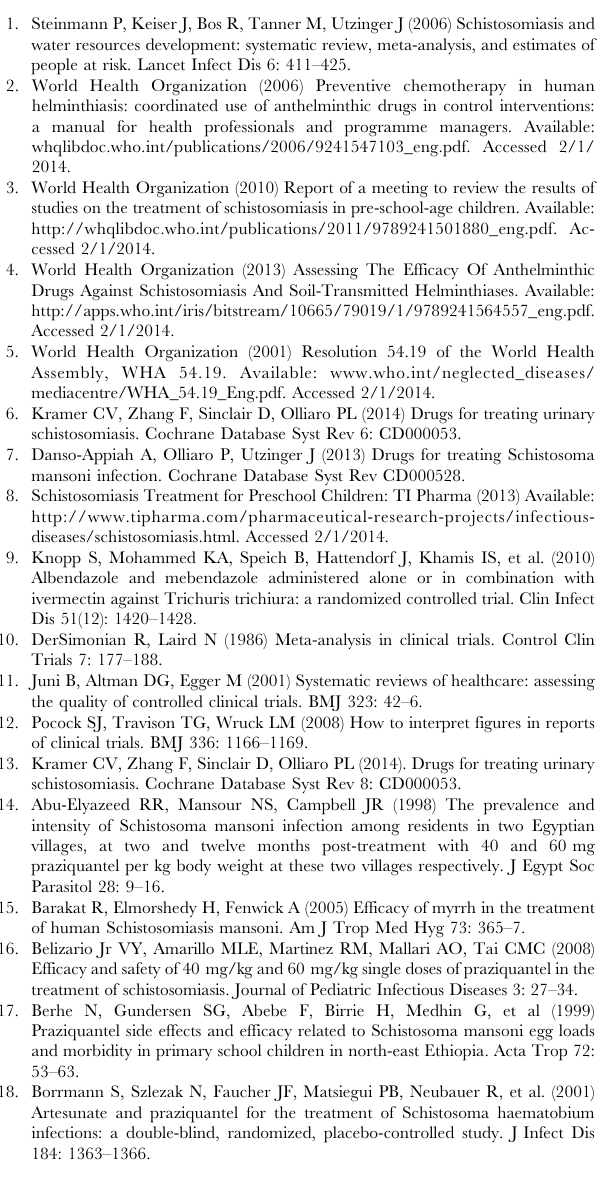
Table S1 Number of patients enrolled by country and species (all treatment arms). Table S2 Study design of the included publications: risks of bias and attrition. Table S3 Classing of studies by age groups based on reported age ranges. Table S4 Diagnostic approaches used in the studies (number of